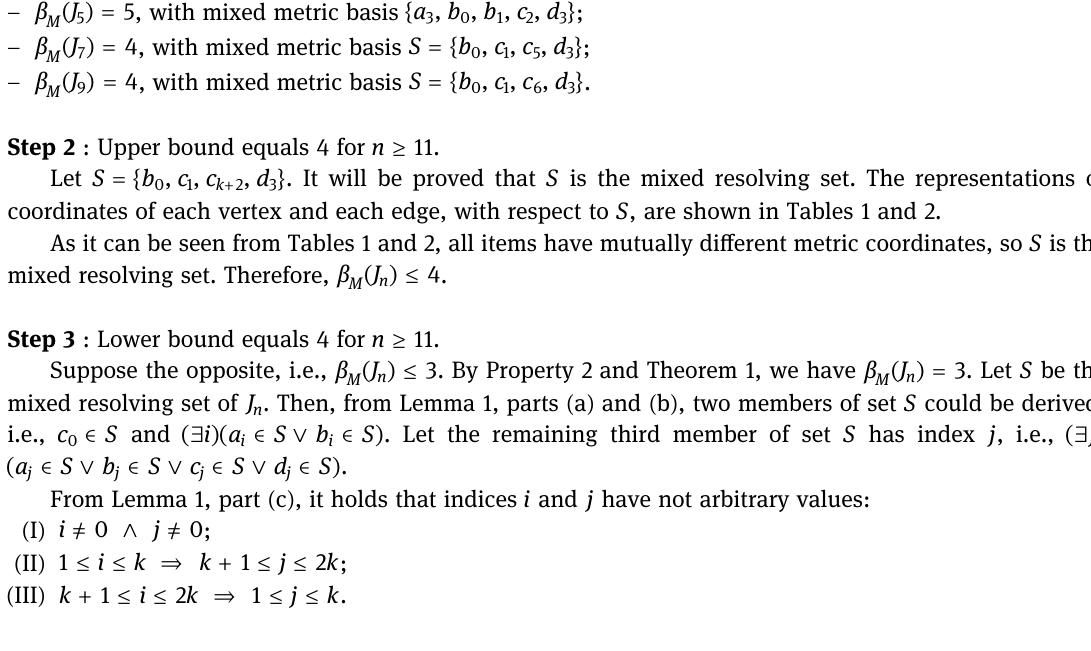
Table 1: Metric coordinates of vertices of J k 2 1 + Vertex